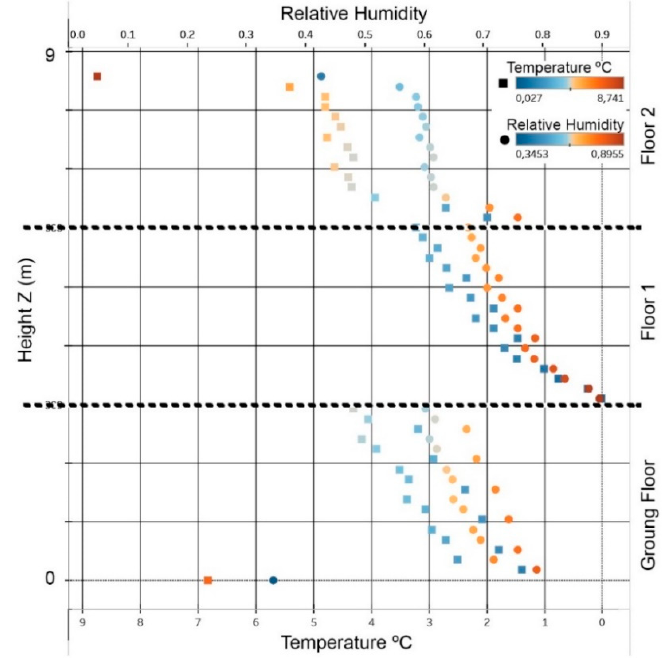
Figure 8. Comparison between relative humidity and temperature to locate possible condensation.